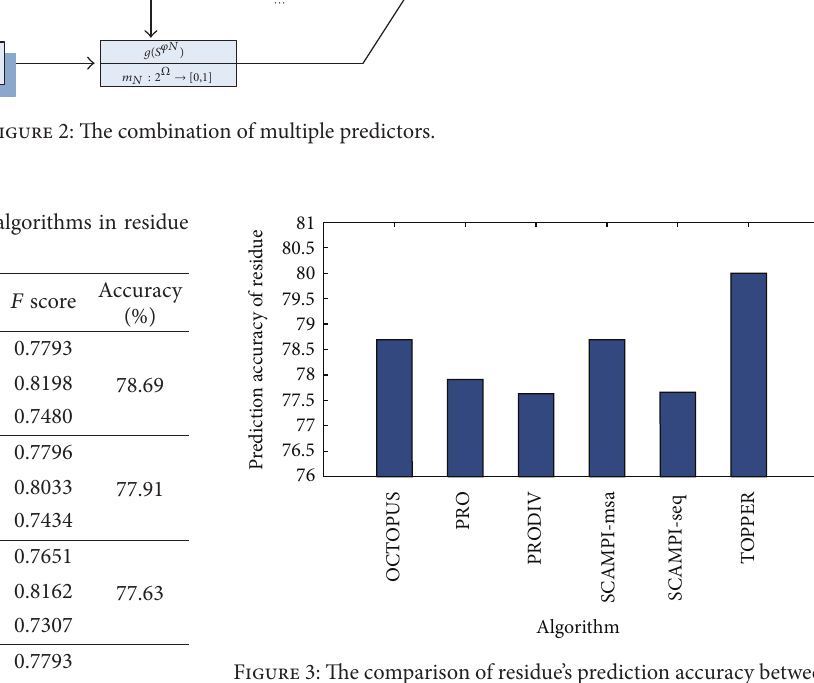
F 3: e comparison of residue’s prediction accuracy between the proposed method and other